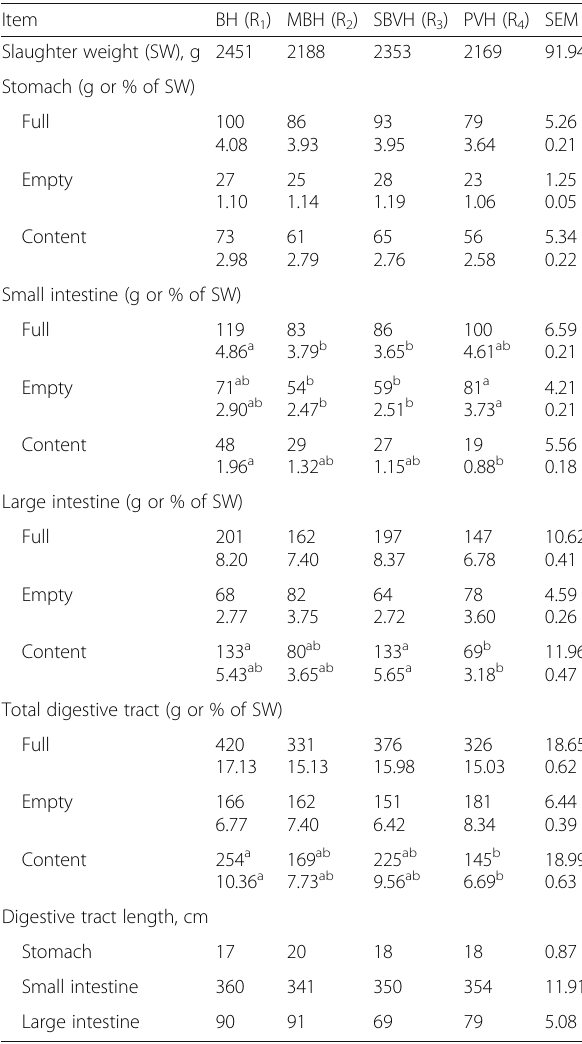
a and b: means in the same row having different superscripts differ significantly ( P